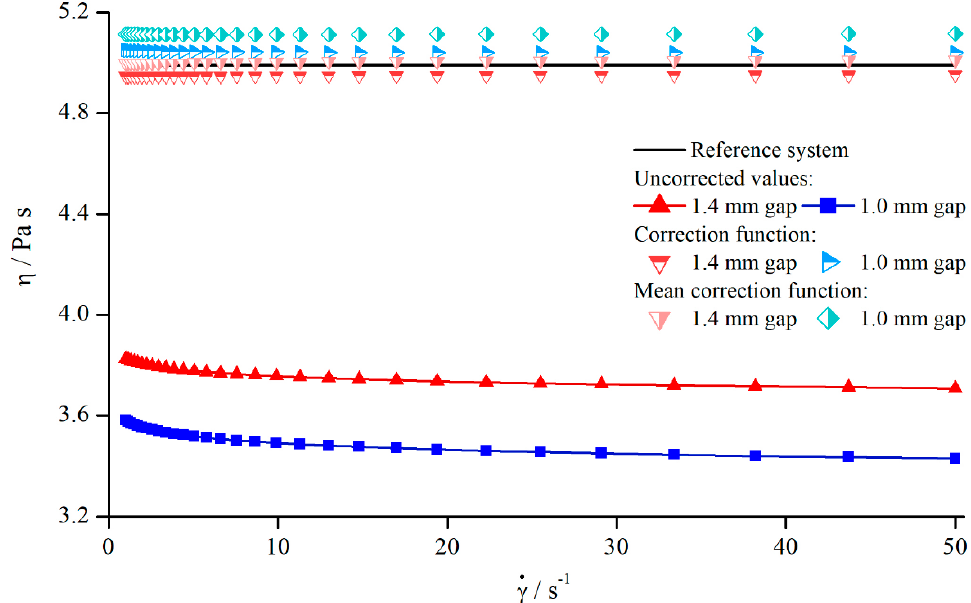
Figure 9. Uncorrected, corrected, and mean correction functions of AK 5000 viscosities, measured with pyramids (system 2).